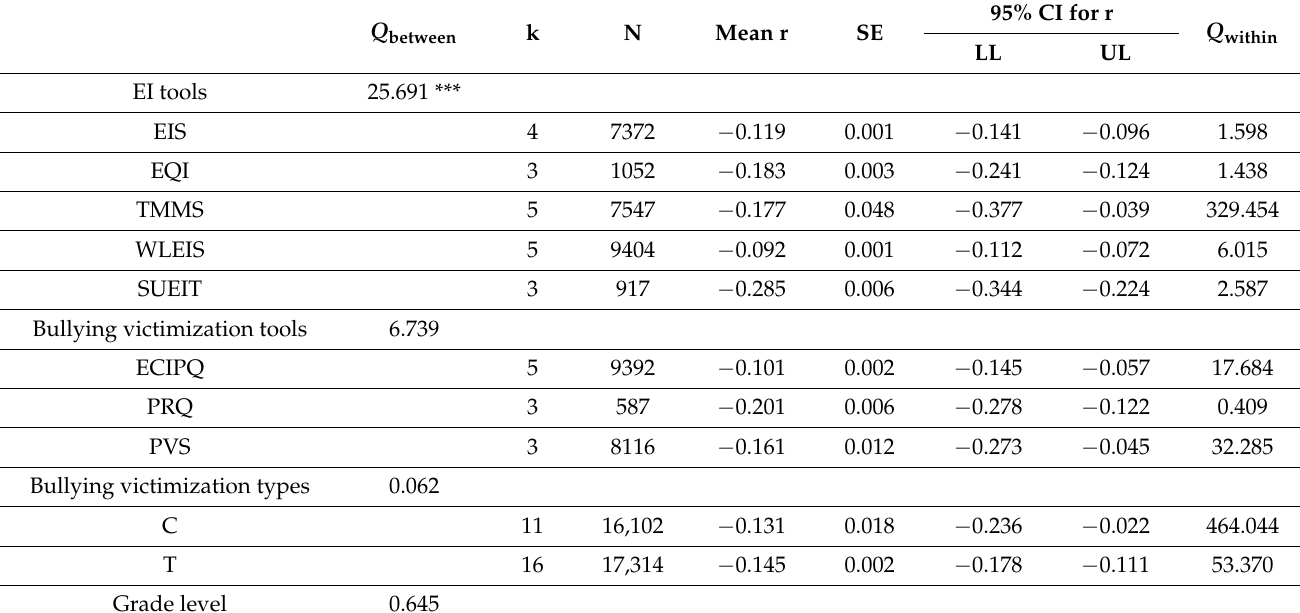
Table 2. Tests of moderators of the bullying victimization links with